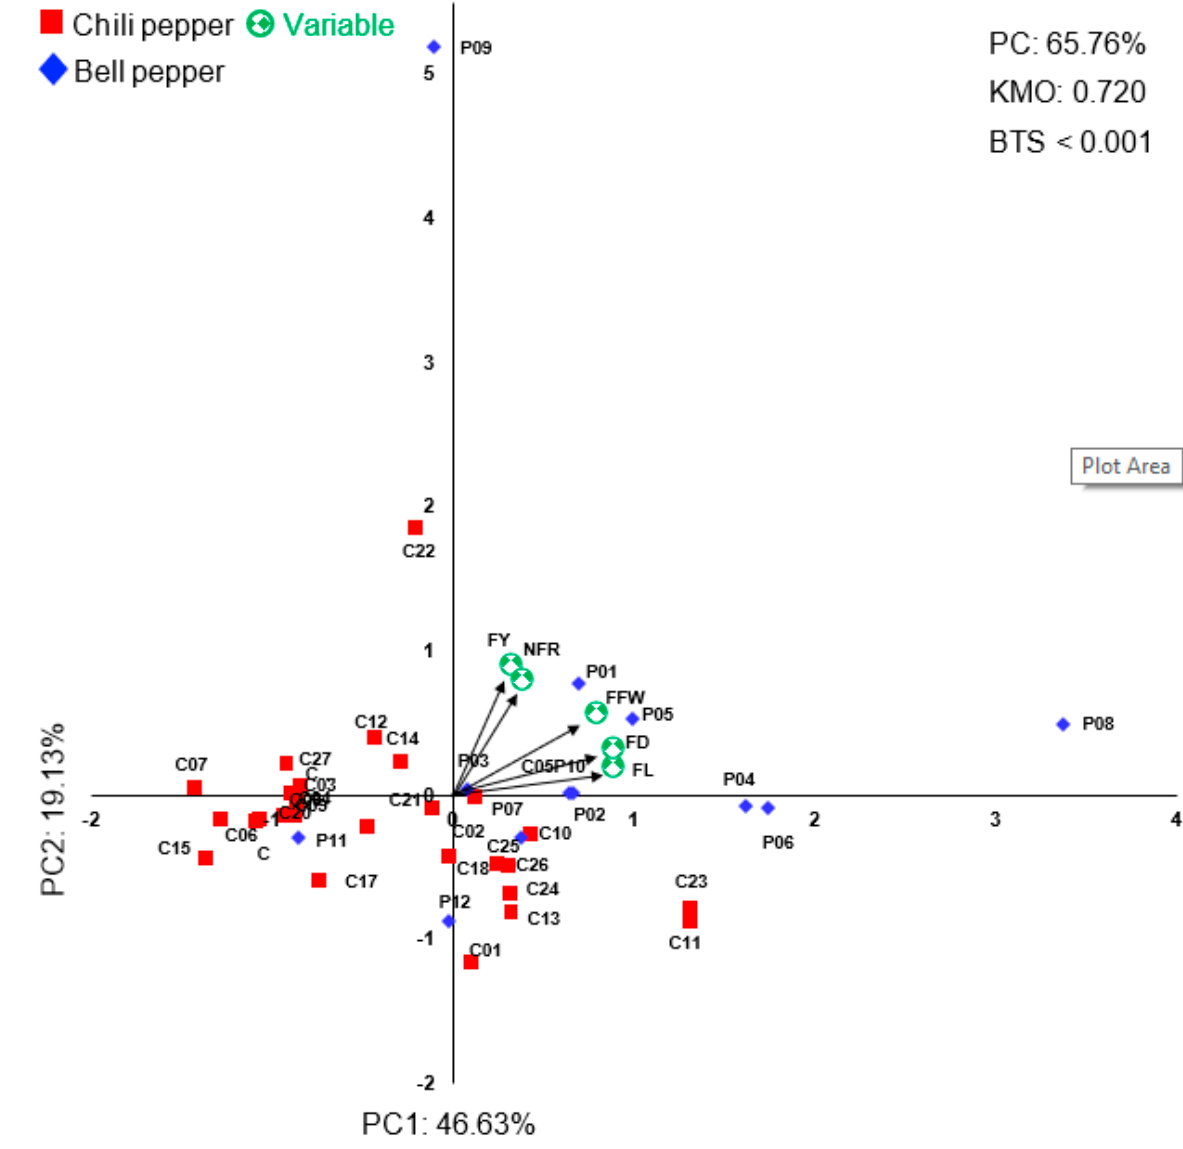
Figure 4. Biplot for first two principal components was analyzed using the principal component analysis (PCA) for 10 agronomical traits among 39 pepper accessions possessing chili (red square) and bell (blue diamond) fruit varieties between LT and CT conditions. The green round circles with multiple diamonds and the arrows represent the variables and the direction of vectors, respectively.